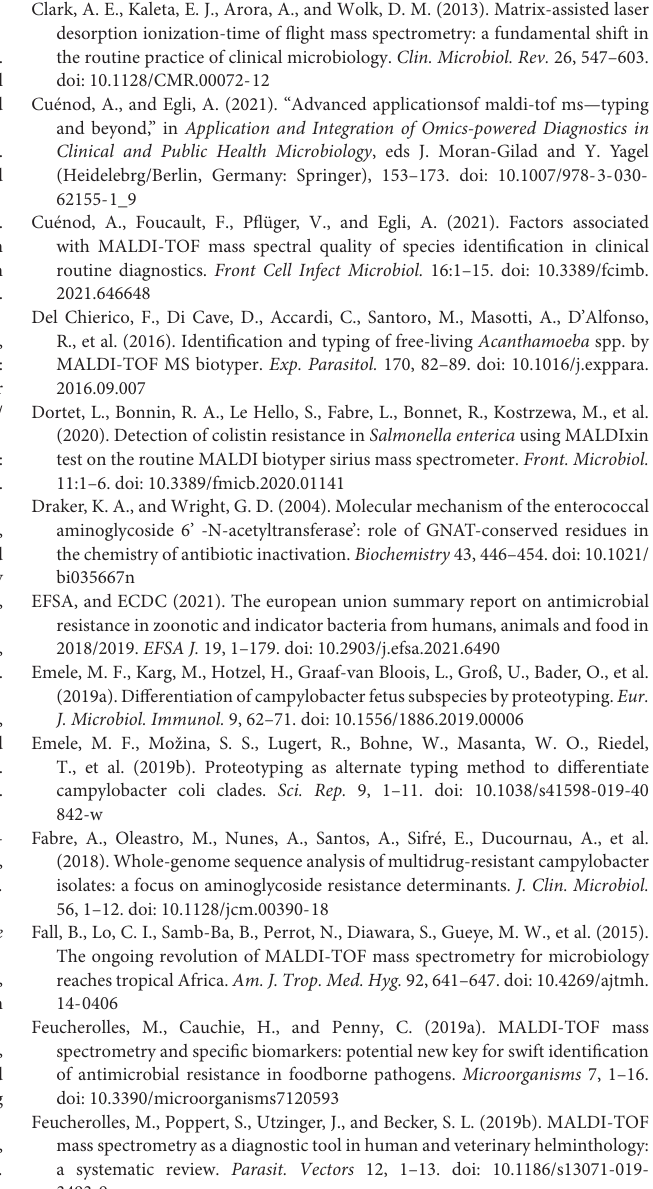
Supplementary File 2 | C. jejuni and C. coli peak matching table for the EtOH/ACN, FA extraction, and direct deposit. Supplementary File 3 | Example of one of the supervised machine learning Python